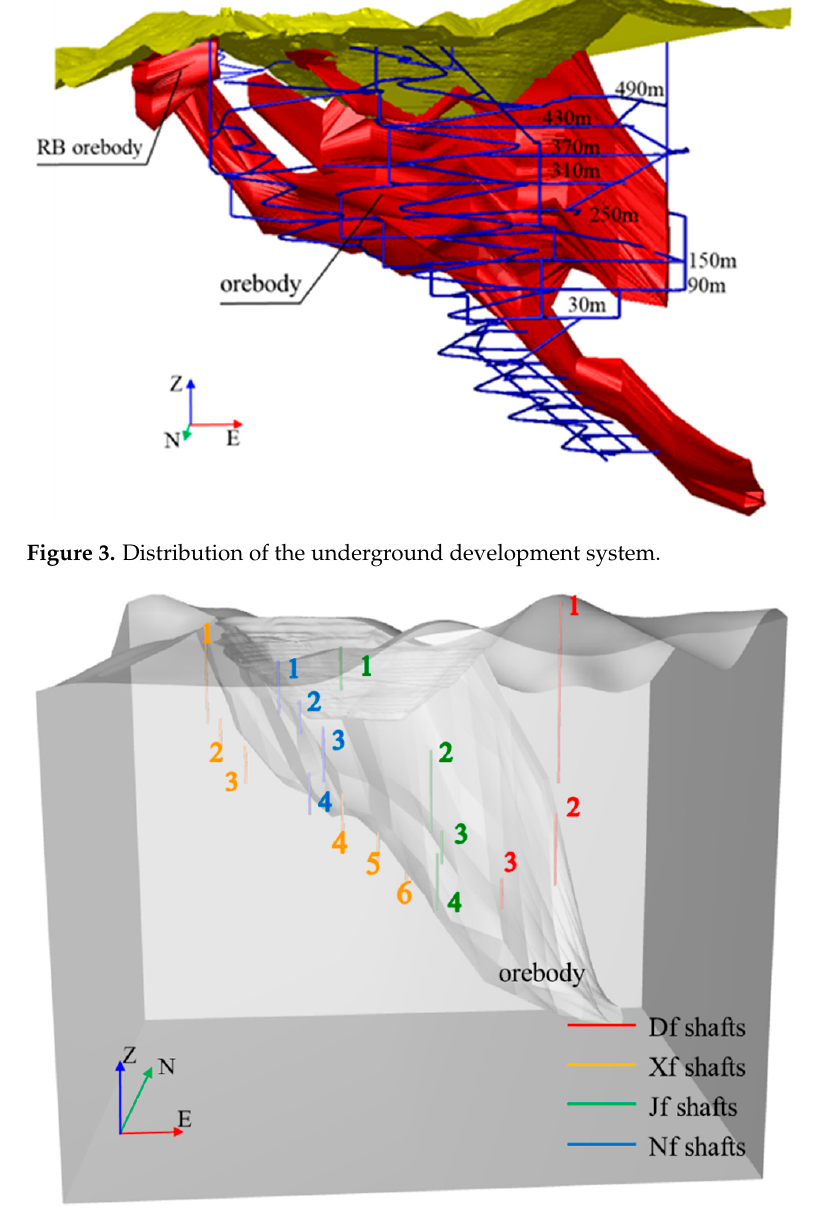
Figure 4. Distribution of four groups of shafts.